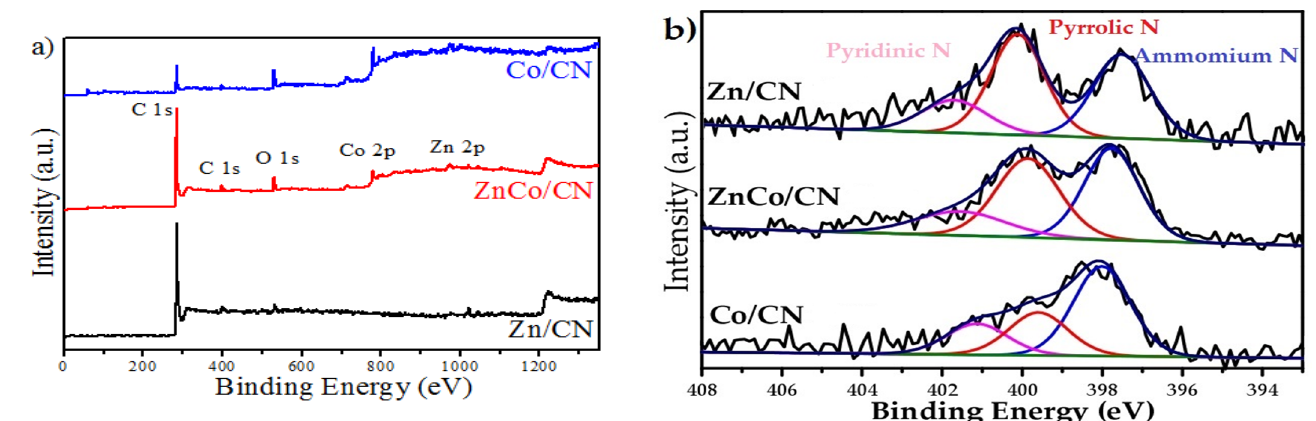
Figure 5. XPS survey analysis of carbonized materials ( a ), High-resolution N 1s spectra of species from different ZIF templates ( b ).